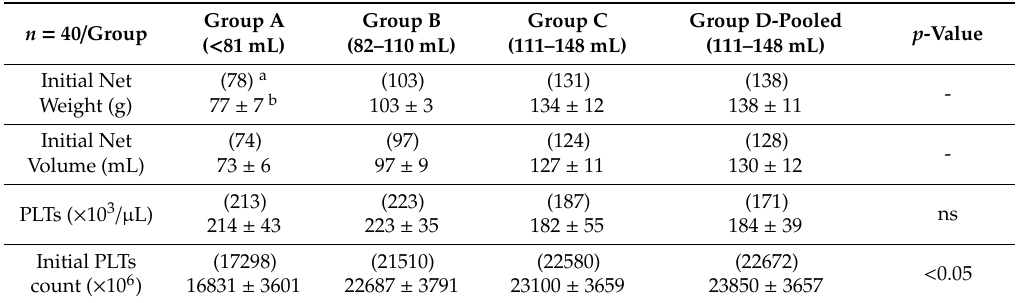
Table 1. Characteristics of cord blood units prior processing, distributed in four groups. Statistically significant di ff erences were observed in initial platelet (PLT) number between all groups ( p < 0.05). a The values represented are medians. b The values are represented as mean ± sd.